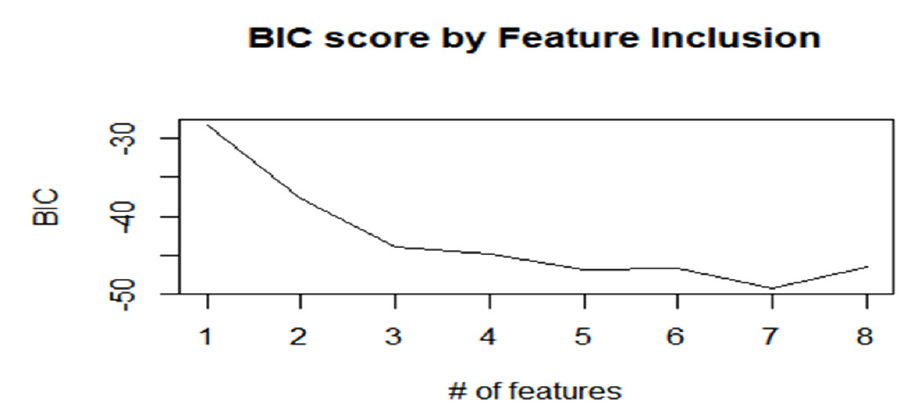
Figure 2. Ridge regression coefficient.